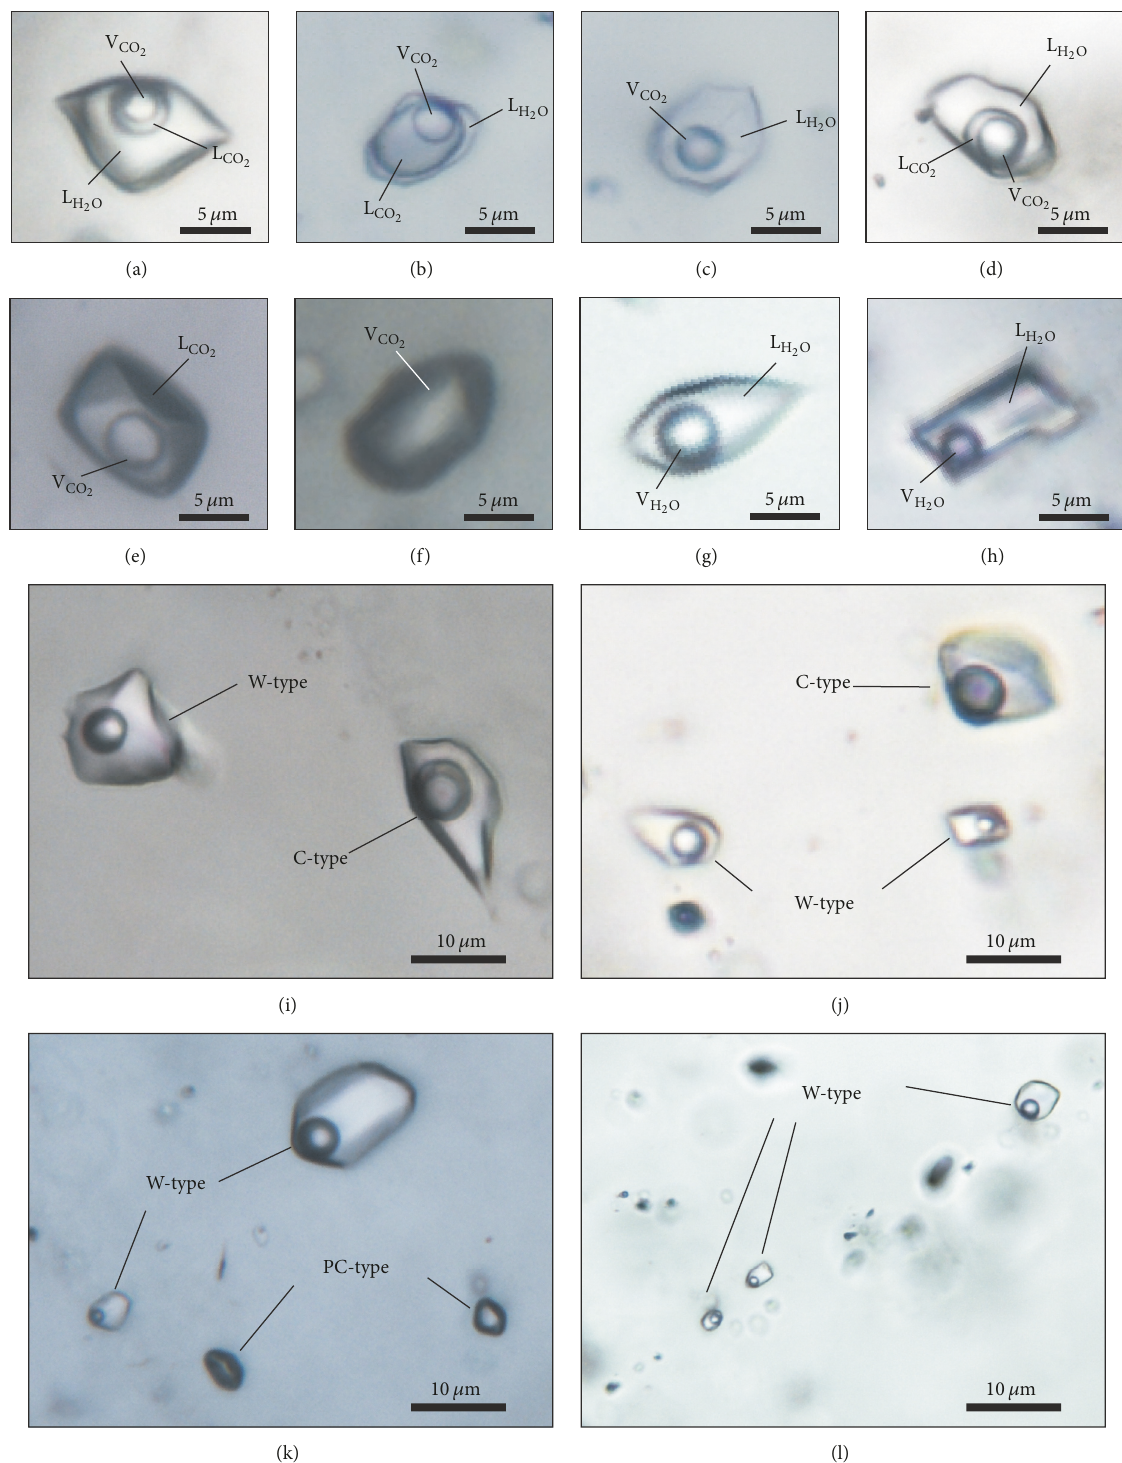
Figure 6: Photomicrographs showing typical fluid inclusions observed in the Liyuan gold deposit. (a) Liquid-rich C-type fluid inclusion in early stage quartz. (b) Vapour-rich C-type fluid inclusion in early stage quartz. (c, d) Liquid-rich C-type fluid inclusions in middle stage quartz. PC-type FIs in early stage (e) and middle stage (f) quartz. (g) W-type fluid inclusion in late stage quartz. (h) W-type fluid inclusion in late stage calcite. (i) Coexisting W-type and PC-type fluid inclusions in middle stage quartz. (j, k) Coexistence of the C-type and W-type fluid inclusions in middle stage quartz. (l) Secondary W-type fluid inclusions in a linear distribution in late stage quartz. V CO L CO : liquid CO 2 ; V H : vapour H 2 O; L H : liquid H 2 2 2 O 2 O